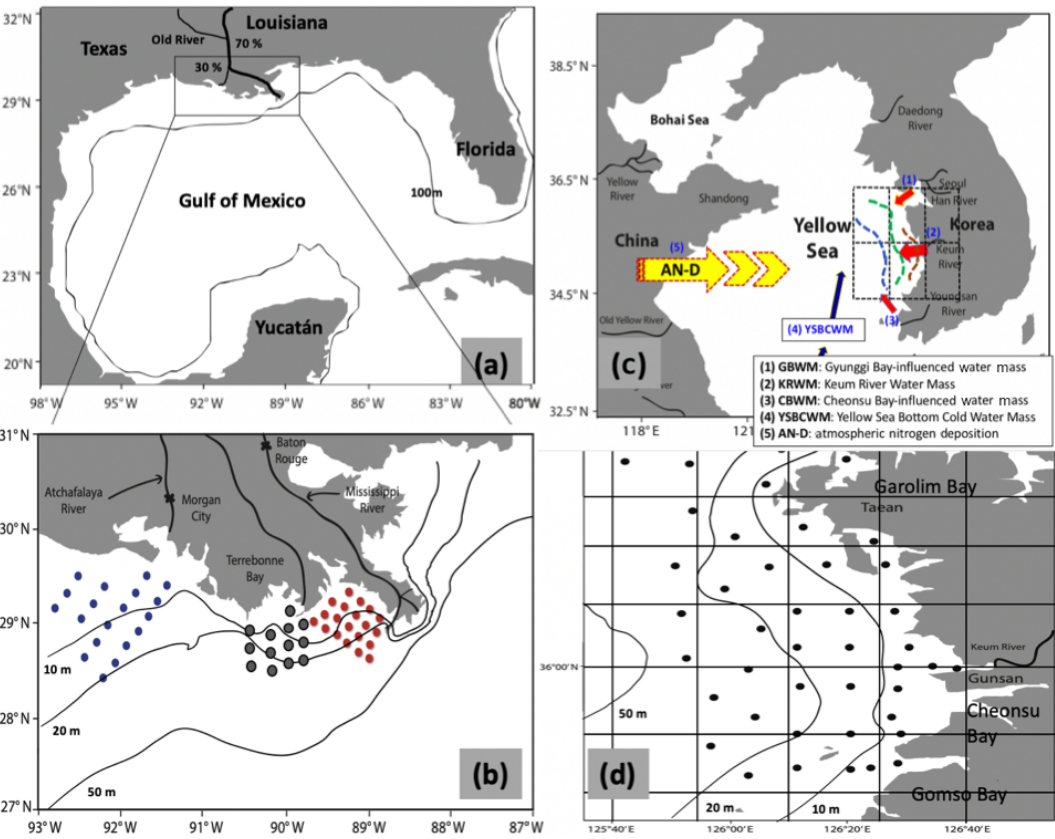
Figure 1. Study sites and sampling areas in the Gulf of Mexico and the Korean Peninsula. Panel (a) shows the sampling area within the northern Gulf of Mexico. Flow in the Mississippi–Atchafalaya river system is split 30% to the Atchafalaya River and 70% to the Mississippi River. The box is the sampling area. Panel (b) shows station positions from March 2005. Note that MCH project data are widely distributed across the region. Red, grey and blue stations correspond to sub-regions A (near the Mississippi River), B (between the Mississippi and Atchafalaya) and C (near the Atchafalaya), respectively. Panel (c) shows the sampling area off the west coast of the Korean Peninsula. Panel (d) shows all of the station